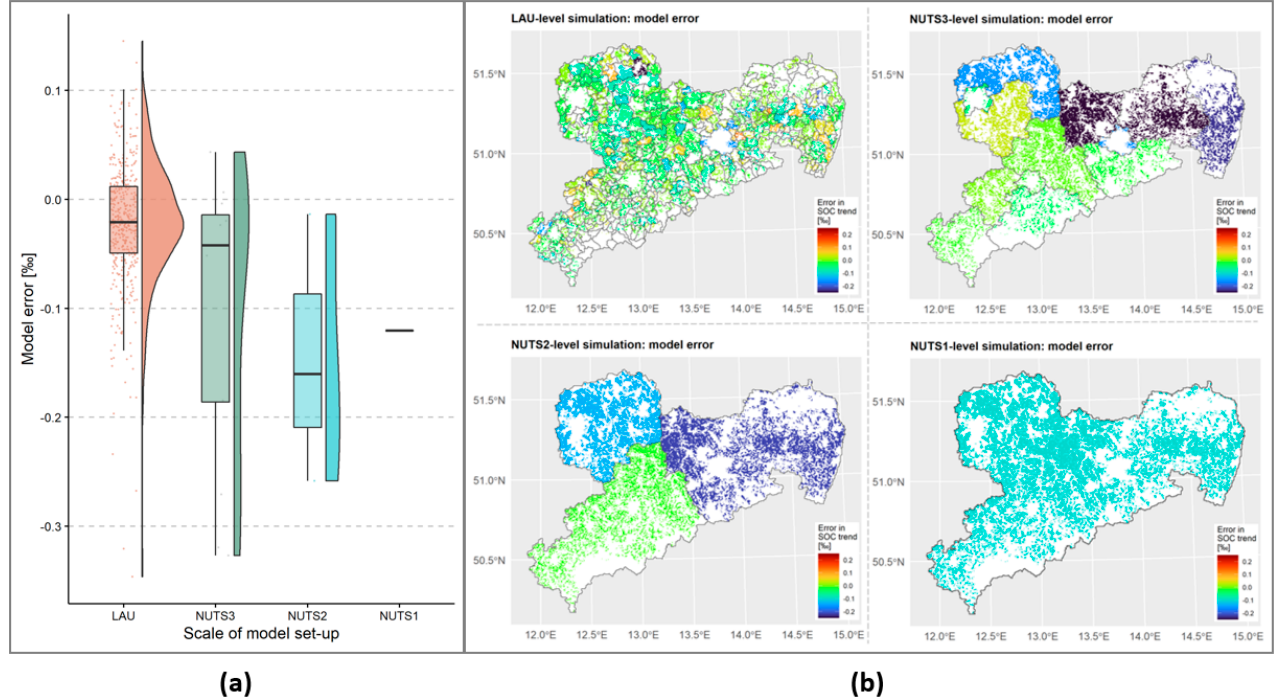
Figure 3. ( a ) Distribution of model errors observed when comparing SOC trends of the upscaled model set-ups with the grid-based reference simulation on the same administrative levels. ( b ) Maps of observed errors in the trend of SOC stocks for upscaled model set-ups. White areas represent non-arable land. ©EuroGeographics for the administrative boundaries.